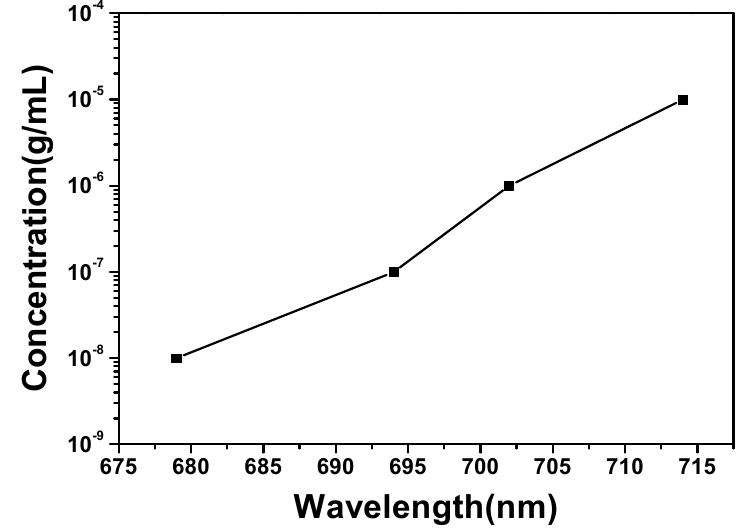
Figure13. Calibration curve for the λ max of LSPRs spectra and log (concentration) of PCB-77. Figure 13. Calibration curve for the λ max of LSPRs spectra and log (concentration) of